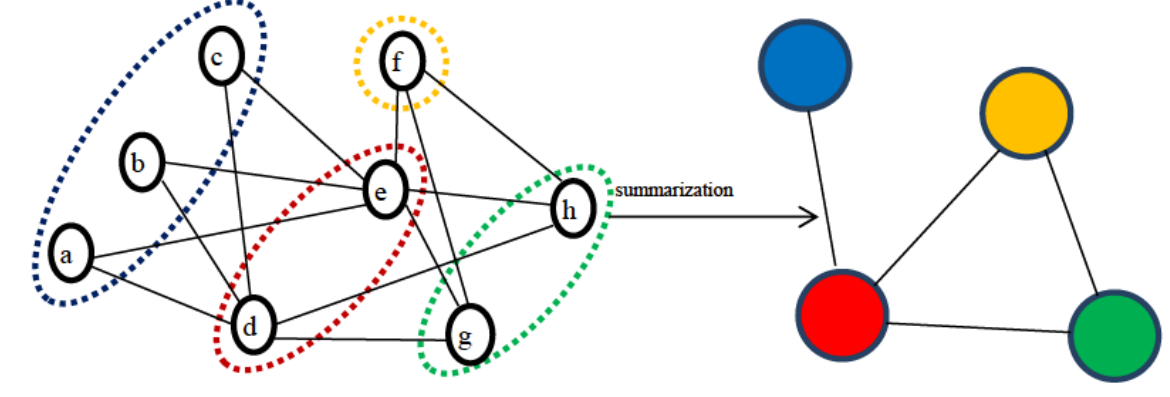
Figure 1: Original graph (left) and its summary (right)